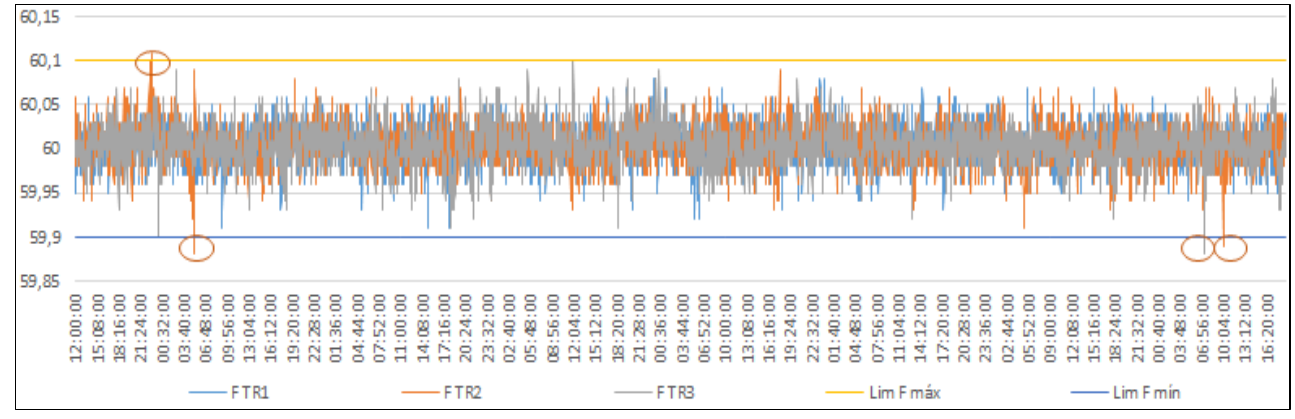
Figure 8: Frequency variation indicator